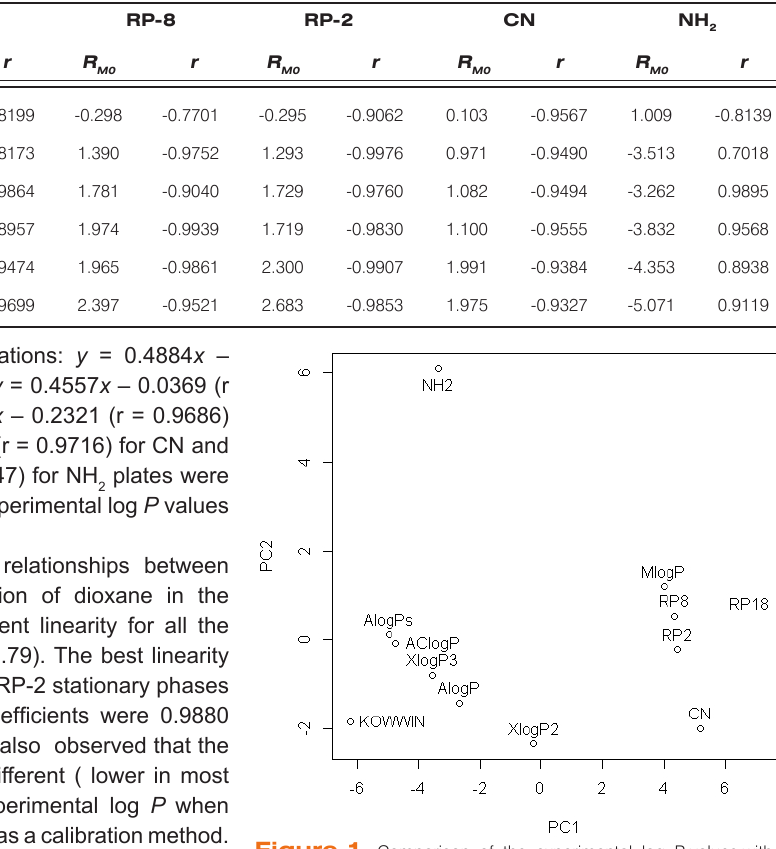
Figure 1. Comparison of the experimental log P values with the computationally calculated coefficients by